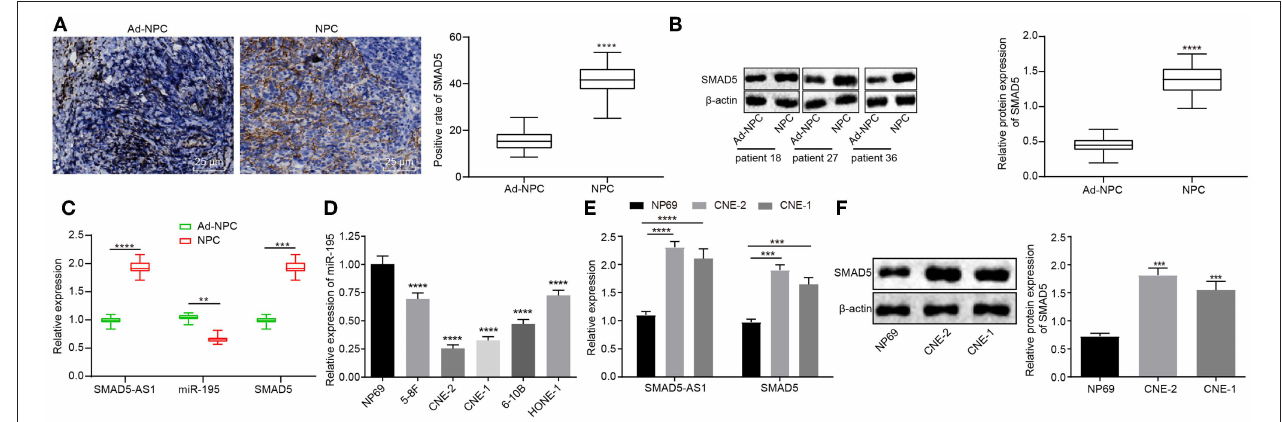
FIGURE 2 | NPC tissues and cells exhibited upregulated SMAD5-AS1 and SMAD5 but downregulated miR-195. (A) The positive expression of SMAD5 protein in NPC tissues and adjacent normal tissues detected by immunohistochemistry (400 × ; scale bar = 25 um; n = 41). **** p < 0.0001 vs. adjacent normal tissues. (B) Protein expression of SMAD5 in NPC tissues and adjacent normal tissues detected by western blot analysis. **** p < 0.0001 vs. adjacent normal tissues. (C) The expression of SMAD-AS1, SMAD5, and miR-195 in NPC tissues and adjacent normal tissues determined by RT-qPCR. **** p < 0.0001, *** p < 0.001, and ** p < 0.01 vs. adjacent normal tissues. (D) The expression of miR-195 in five NPC cell lines and a normal cell line measured using RT-qPCR. **** p < 0.0001 vs. NP69 cells. (E) The expression of SMAD5 mRNA and SMAD5-AS1 in CNE-2, CNE-1, and NP69 cells determined by RT-qPCR. **** p < 0.0001, *** p < 0.001 vs. NP69 cells. (F) Expression of SMAD5 protein in CNE-2, CNE-1, and NP69 cells determined by western blot analysis. *** p < 0.001 vs. NP69 cells. The data were measurement data, which were presented as mean ± standard deviation. Paired t -test was performed for comparisons between adjacent normal tissues and NPC tissues, independent sample t -test was applied to compare the differences between two groups, and one-way analysis of variance was employed to compare the differences among multiple groups, followed by Tukey’s post-hoc test. The experiment was repeated three times.